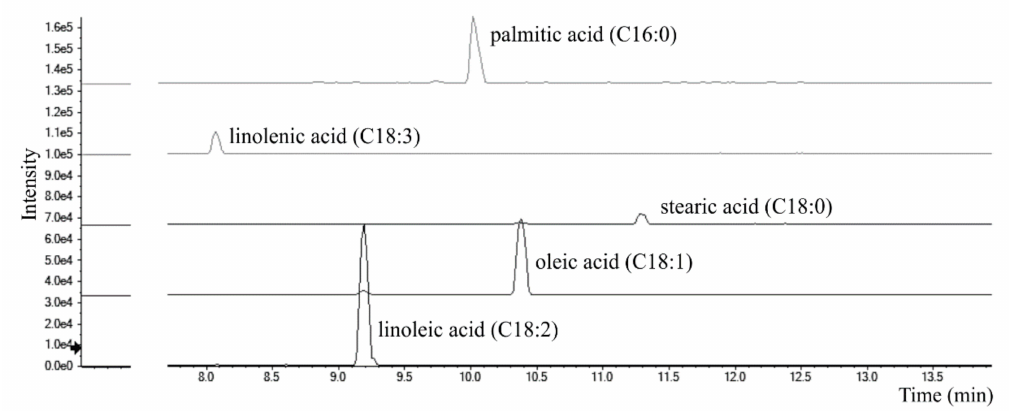
Figure 9. Extracted Ion Chromatograms (XICs) of fatty acids tentatively identified in Cf-O